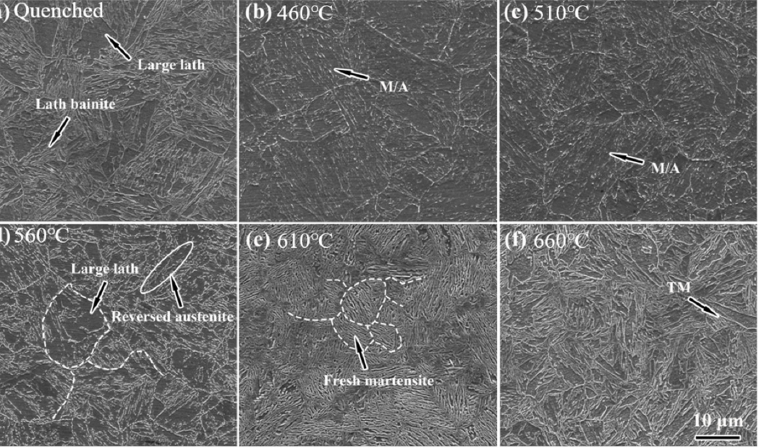
Figure 7. SEM images of the Fe-9Ni-2Cu steel with the increase of temperatures. ( a ) Quenched; ( b ) 460 °C; ( c ) 510 °C; ( d ) 560 °C; ( e ) 610 °C; ( f ) 660 °C. ( b ) 460 ◦ C; ( c ) 510 ◦ C; ( d ) 560 ◦ C; ( e ) 610 ◦ C; ( f ) 660 ◦